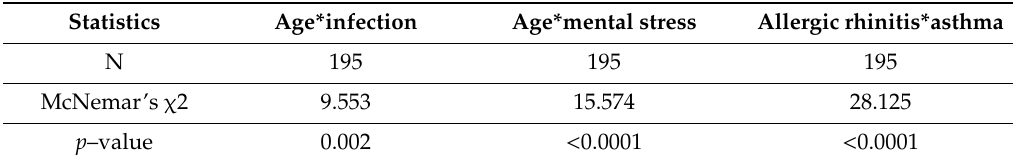
Table 10. McNemar’s χ 2 quadratic test for dependent samples, for testing the significance of di ff erences between the variables age*infection, age*mental stress and allergic